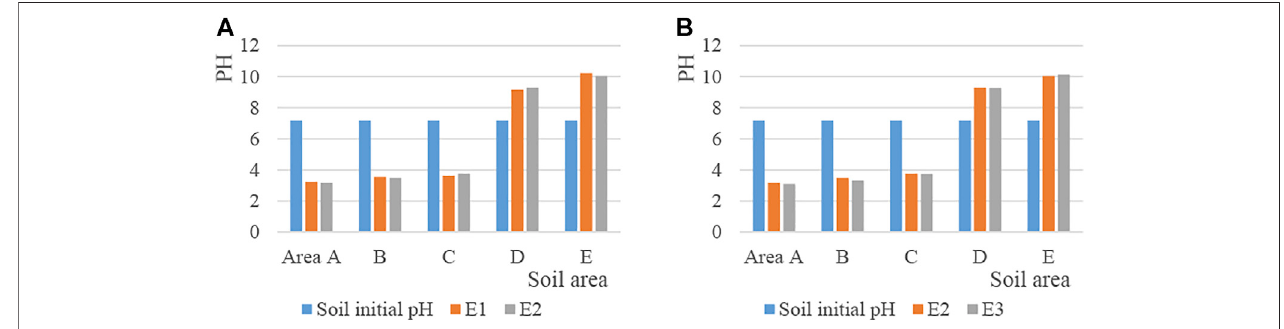
FIGURE7| VariationofsoilpHunderdifferentexperimental conditions. (A) showstheeffectofelectrolytetypesonsoilpH. (B) showstheeffectofremediationtime on soil pH.